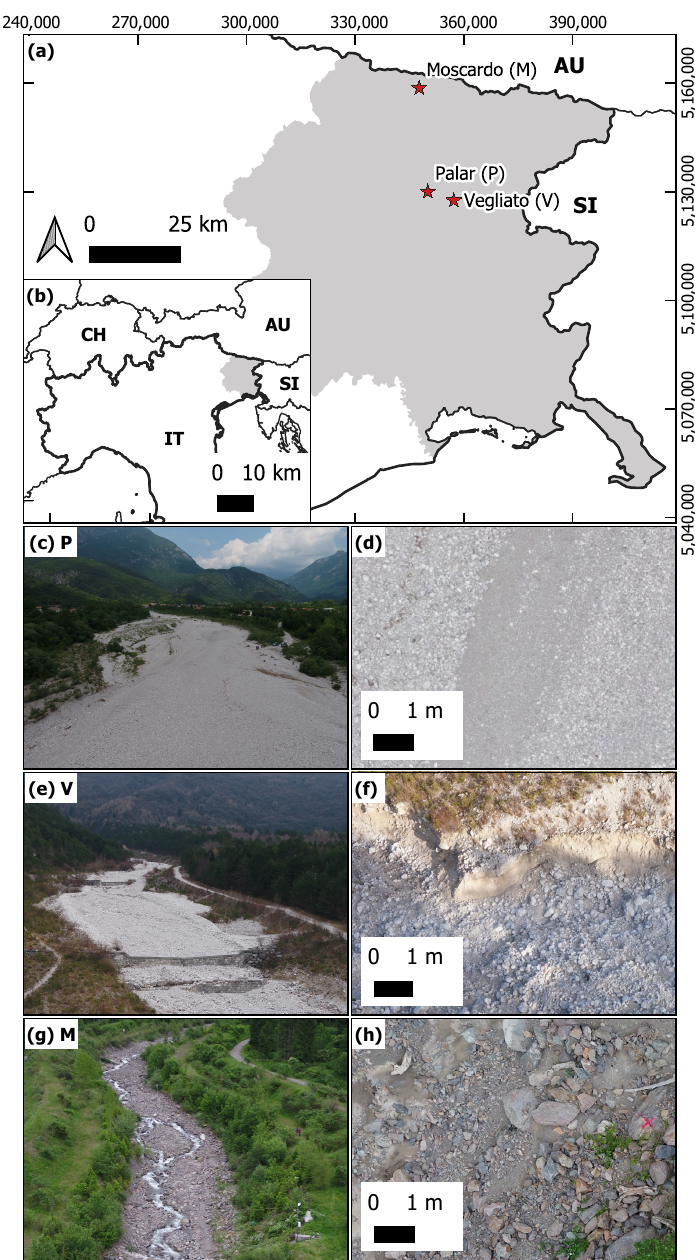
heterogeneous morphologies due to the presence of torrent control works (i.e., three check dams), river banks and fluvial terraces (Figure 1f) and the reach has a slope of 16%. The third study site (Moscardo—M) is located within the Moscardo catchment (Figure 1g—46°33 (cid:48) 50.53 (cid:48)(cid:48) N, 13°0 (cid:48) 43.60 (cid:48)(cid:48) E) and has an extension of 0.12 ha with a slope of 12%. This last one presents high heterogeneity in terms of roughness pattern and granulom- etry, with size ranging from sand to gigantic boulders, as shown in Figure 1h. This is mainly due to debris-flow events which reach very frequently the study area [26]. These particular events influence the reach morphology and cause the presence of different sediment size, from clay particles to boulders (diameter > 1 m).